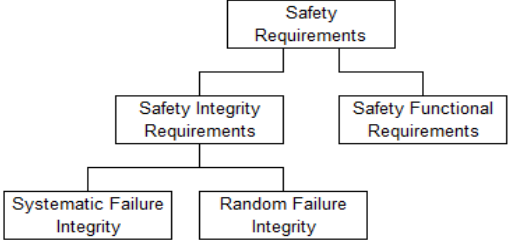
Figure 3. Safety requirements and safety integrity (EN